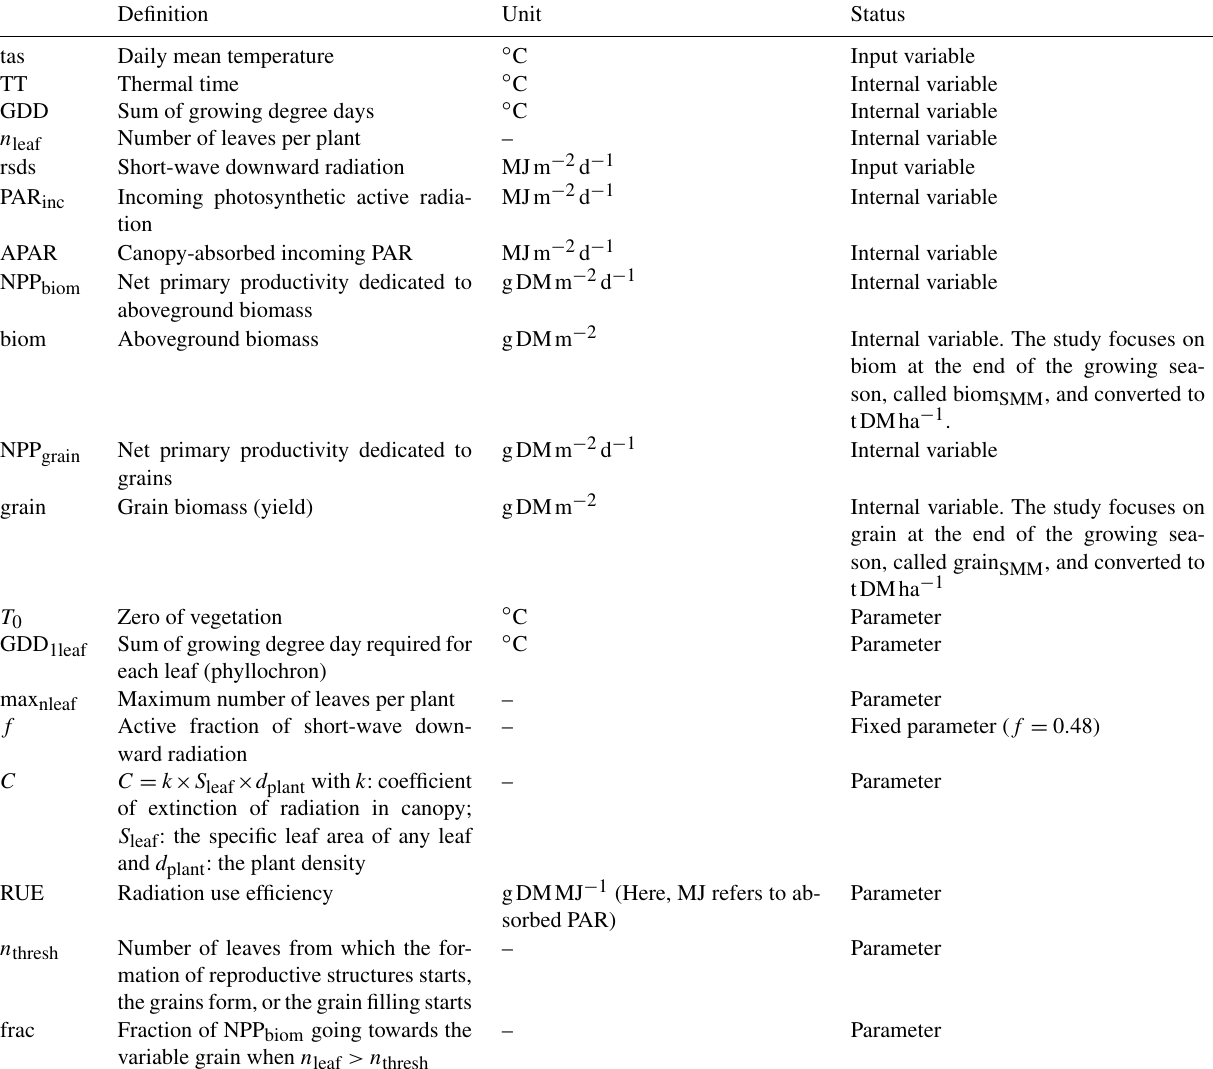
Table 1. List of variables and parameters in